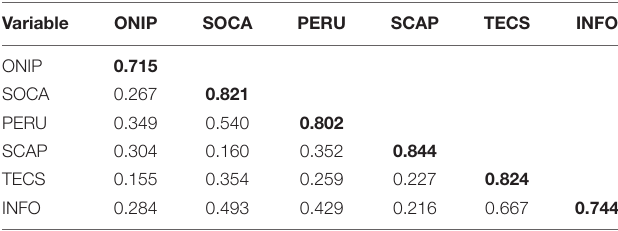
TABLE 5 | The discriminant validity of the Fornell and Larcker.